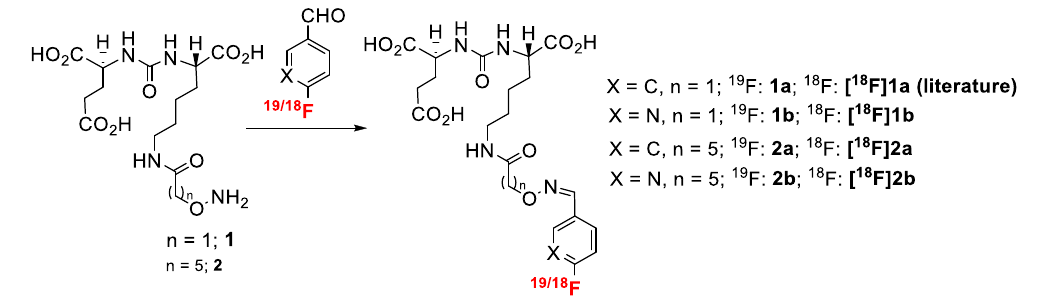
Scheme 1. Structures of the compounds investigated in the current study.